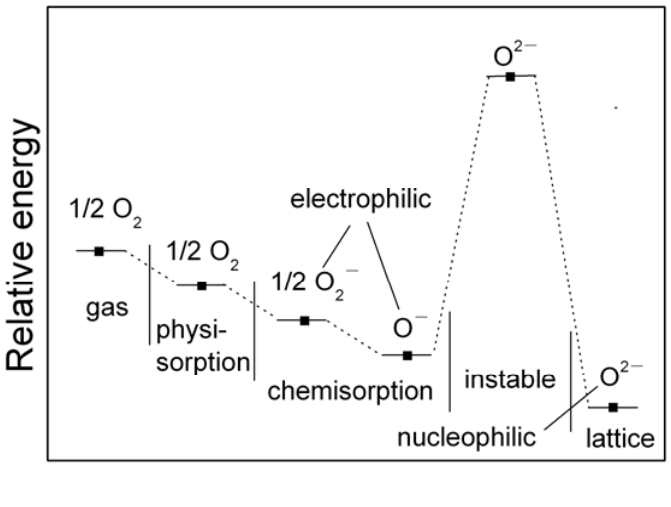
. Reprinted with permission from 2